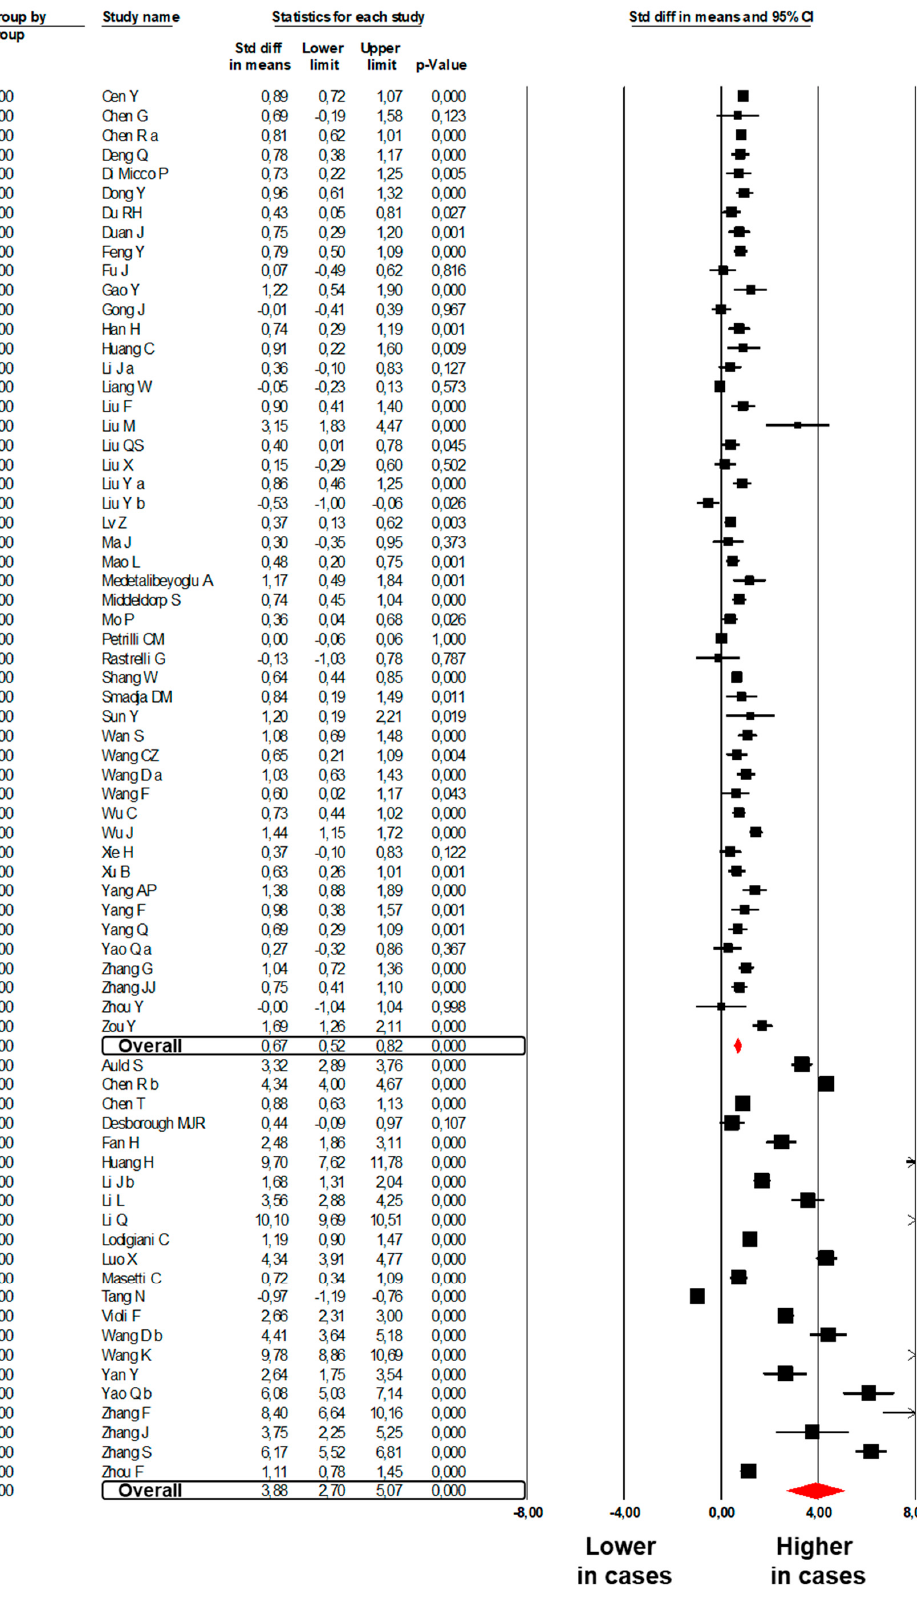
Figure 3. Forest plots of the difference in D-Dimer values between subjects with severe and those with mild COVID-19 (Group 1) and between non-survivors and survivors to COVID-19 (Group 2).